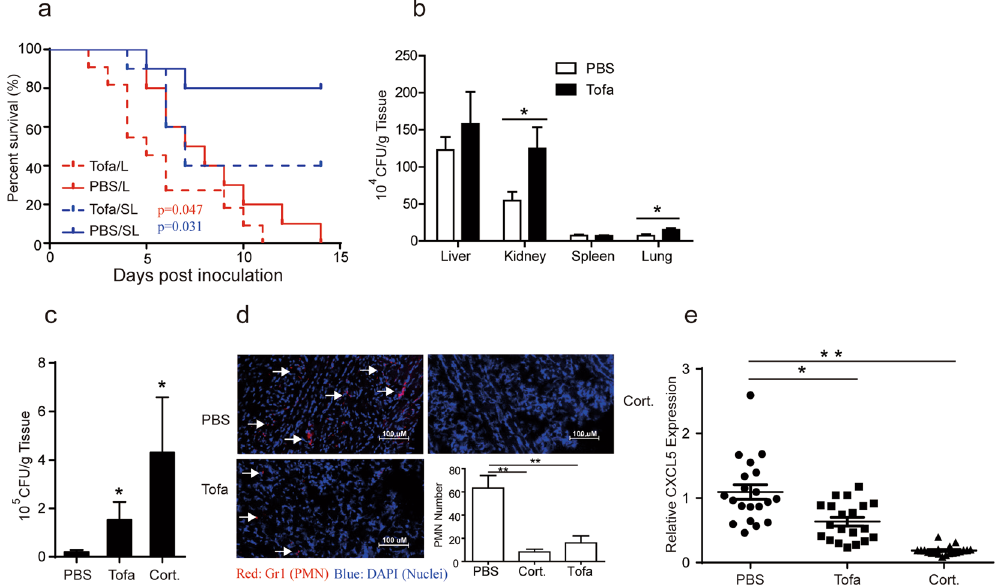
Figure 1. Tofacitinib increases the susceptibility of mice to C. albicans infection. ( a ) Survival curves of BALB/c mice (10 per group) after lethal (10 7 CFU/mouse, i.v.), or sub lethethal (5 × 10 6 CFU/mouse). C. albicans challenge followed by twice a day i.p. injections of tofacitinib at 15 mg/kg ( Tofa/L and Tofa/SL , respectively), or PBS as control ( PBS/L and PBS/SL , respectively). ( b ) Effect of tofacitnib on systemic C. albicans infection. BALB/c mice (5 per group) were given 2 i.p. injections (with 12 h intervals) of tofacitinib, or PBS as control, and then a lethal dose live C. albicans followed by 2 more injections of the same preparations on day 2. The animals were sacrificed 24 h post infection for assessment of C. albicans burdens in their livers, kidneys (both sides), spleens and lungs. The results are expressed as CFUs per gram tissue. ( c ) Effect of tofacitnib on mucosal C. albicans infection. BALB/c mice (8 per group) were given i.p. injections of tofacitinib ( Tofa ), or PBS, twice a day (with 12 h intervals) for 5 days. An additional group of mice was given 3 i.p. injections of cortisone acetate